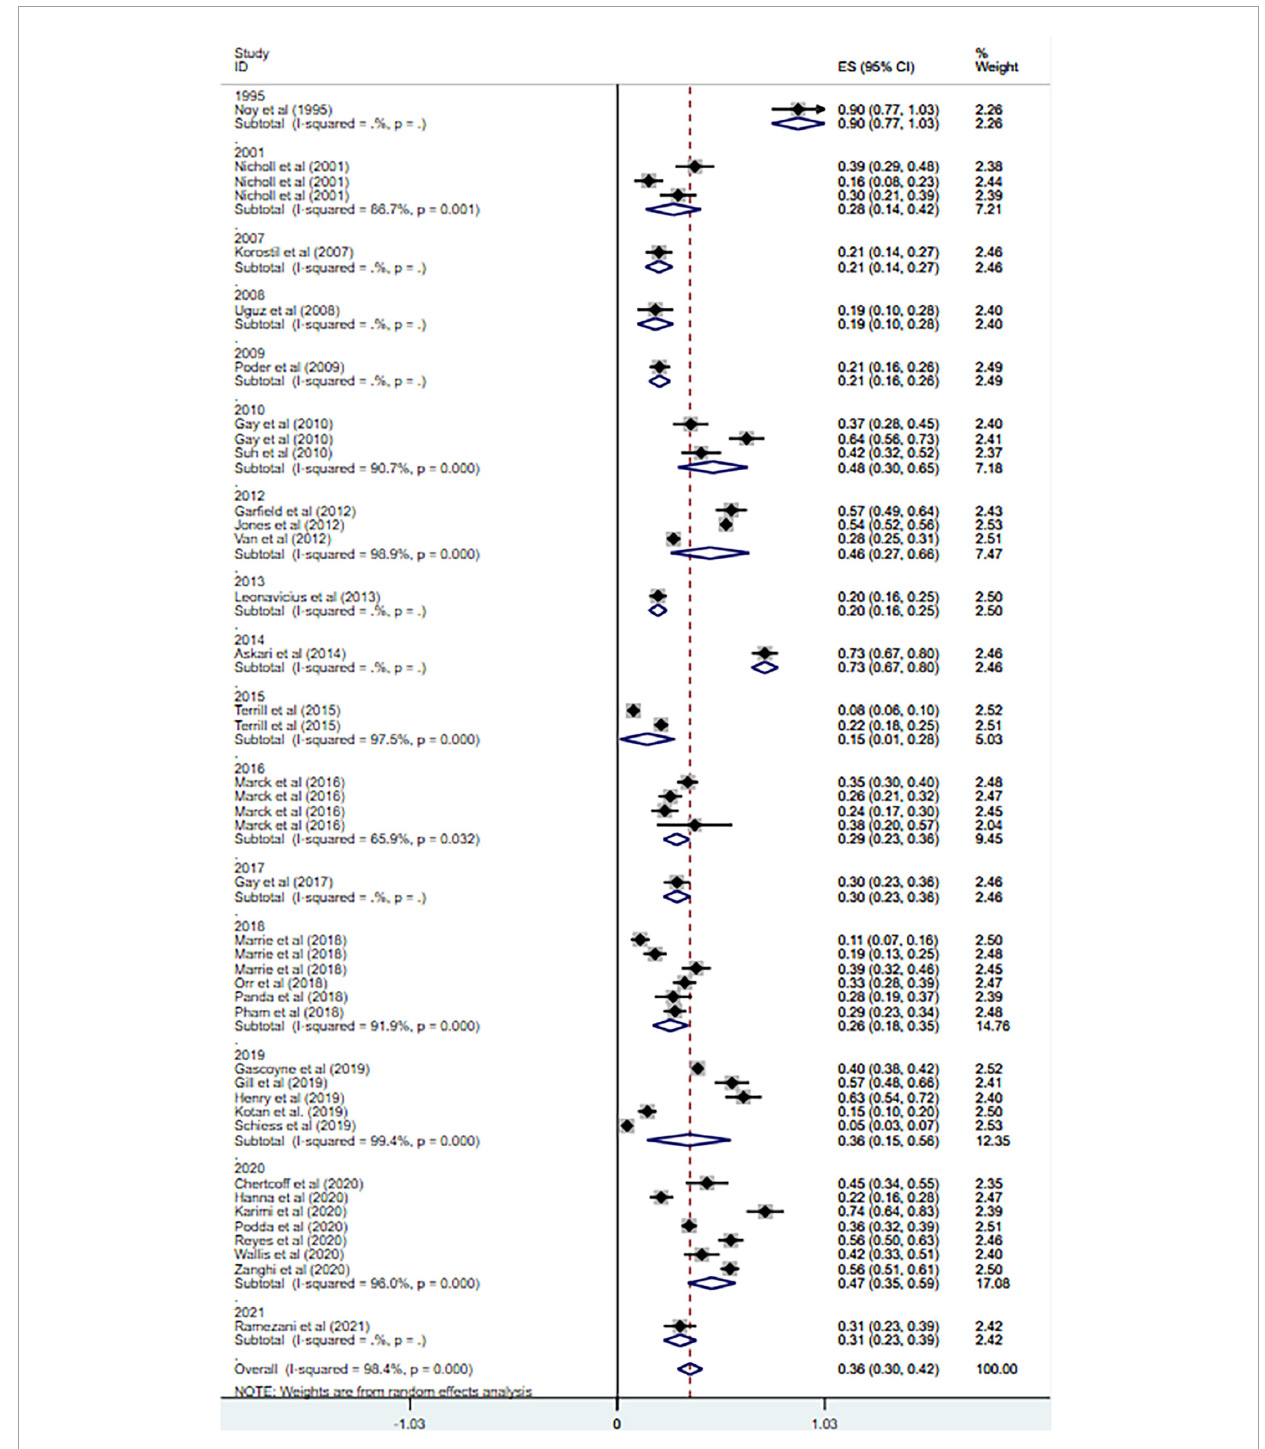
FIGURE5 Forest plot of subgroup analysis on changes of prevalence of anxiety in MS based on publication